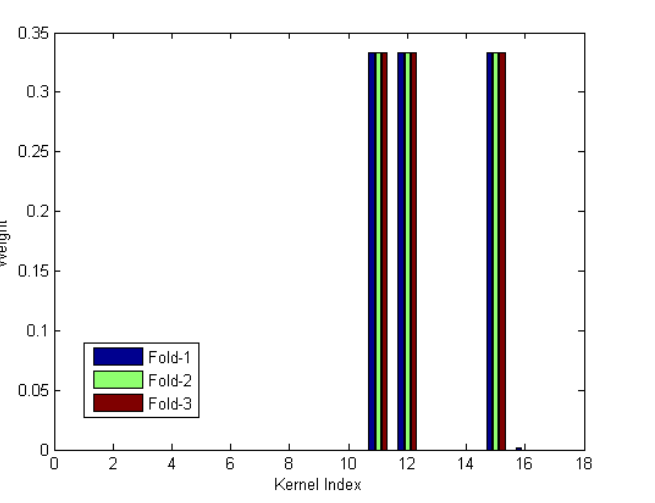
Figure 2. Bar plot showing the weights derived by DiMKL 1 for each Fold.